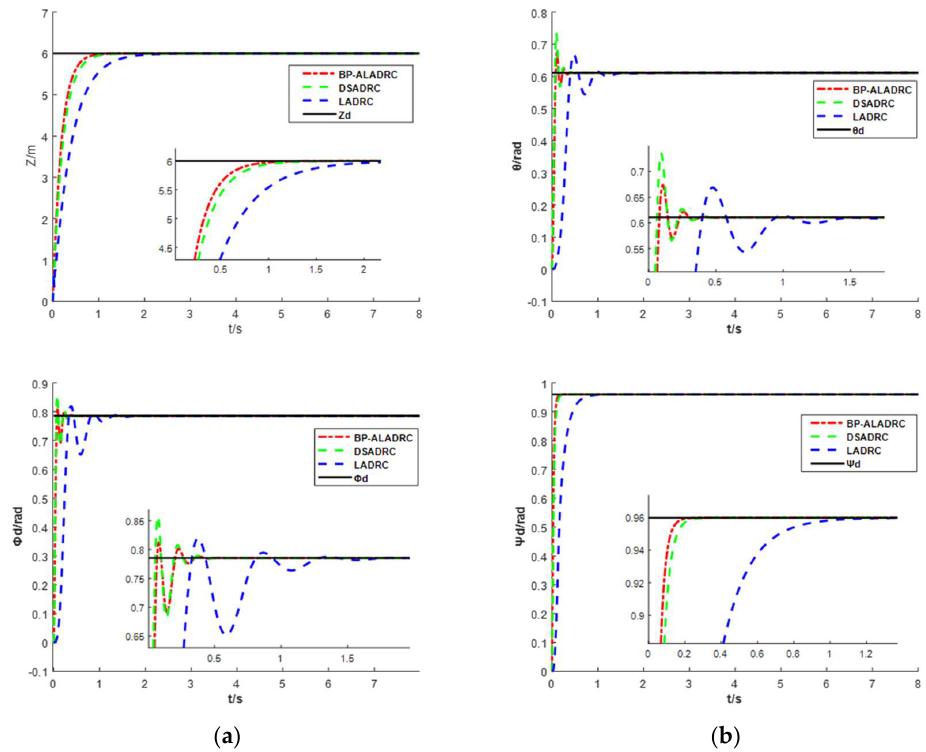
Figure 4. System output: ( a ) Altitude and Roll angle output; ( b ) Pitch and Yaw angle output.